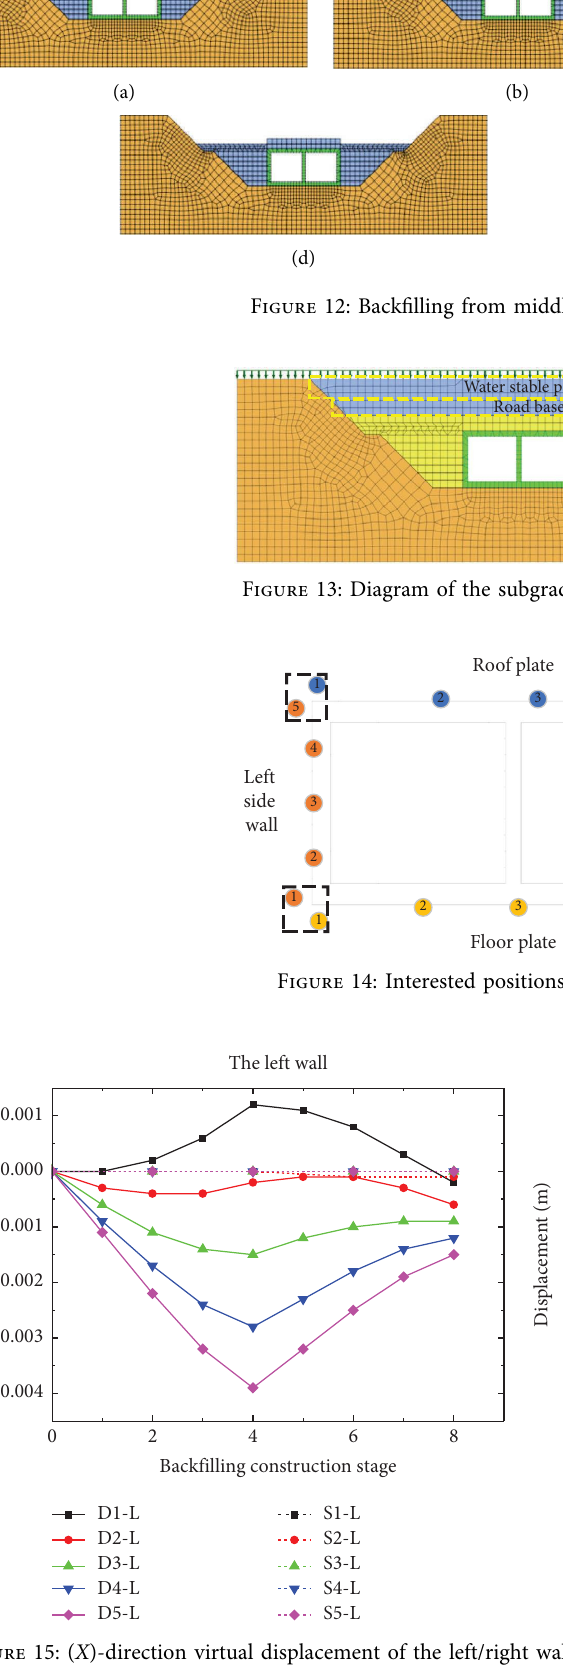
Figure 15: ( X )-direction virtual displacement of the left/right wall in unilateral and bilateral backfll modes,